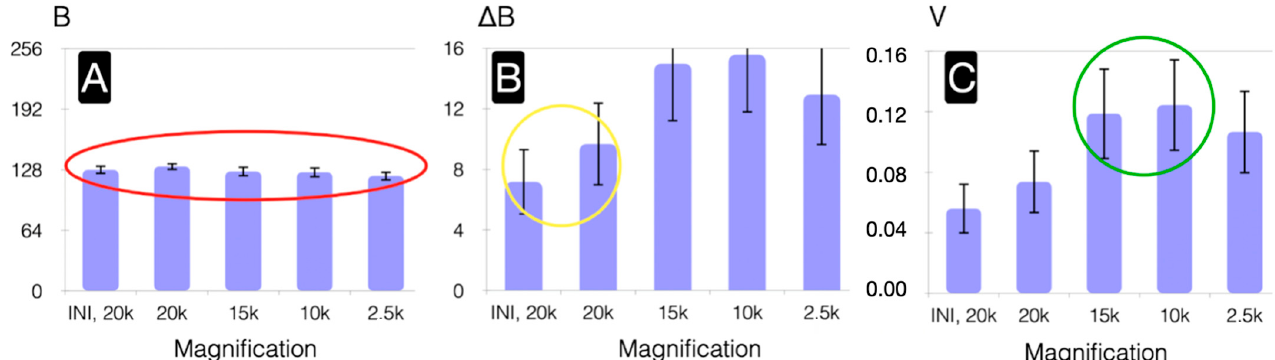
Figure 9. The variation-rotational pictures for the initial—( A ) and the modified—( B – E ) samples obtained from the SEM images of different magnification: 20 k—( A , B ); 15 k—( C ); 10 k—( D ); and 2.5 k—( E ). Figure 10. The mean ( A ), standard deviation ( B ), and variation coefficient ( C ) values for the variation-rotational pictures obtained from the SEM images under the different magnification levels (2.5 k; 10 k; 15 k, and 20 k). (INI—initial sample at 20k magnification; others—modified, different magnification). The red ellipse and yellow and green circles are explained in the text.